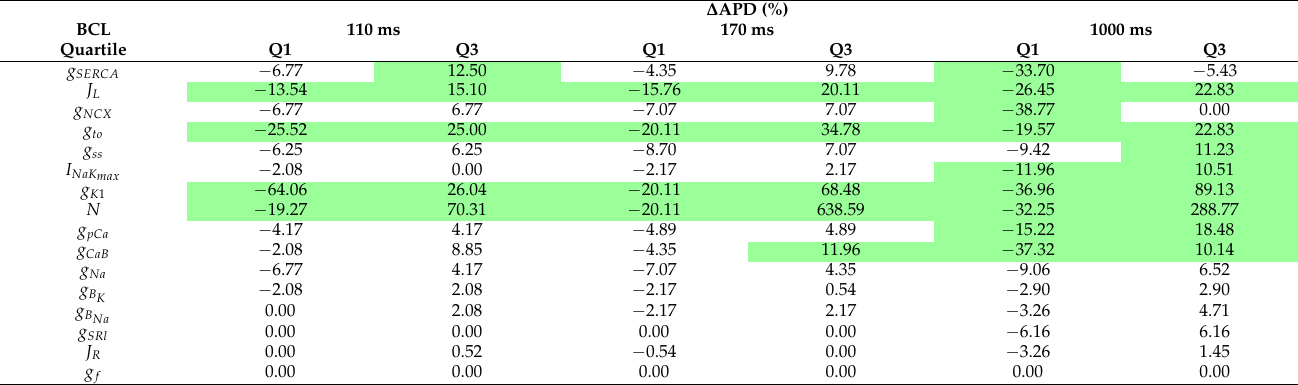
Table A1. Effects of uni-parametric variation on APD in the Gattoni2016 cellular model. Distributions of the relative increments in APD ( ∆ APD = (APD v − APD r )/APD v * 100%, APD v − APD values with varied parameters; APD r —reference value) were evaluated. The first (Q1) and third (Q3) quartiles (the range for 50% of distribution samples around the median) are shown. Green cells indicate effects greater than ±